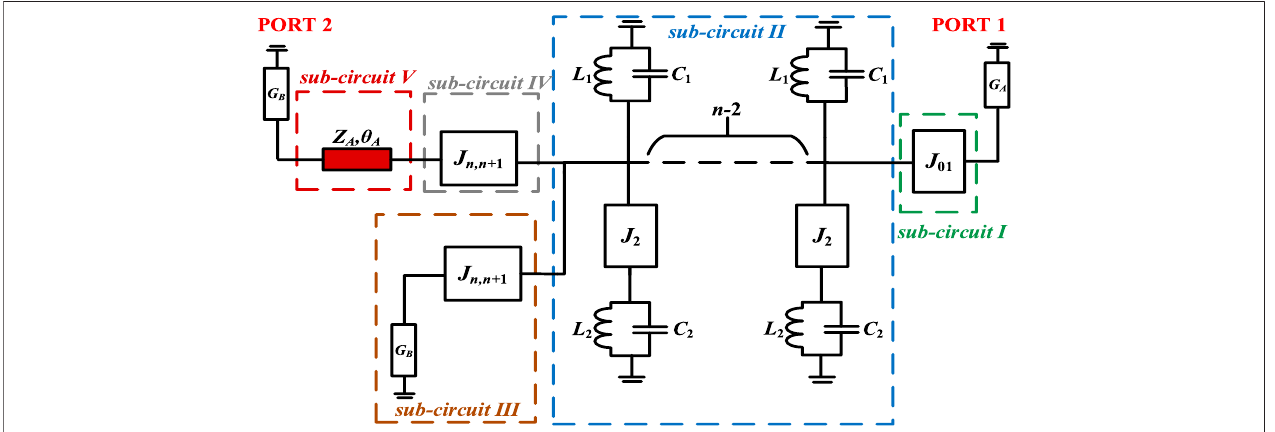
FIGURE 2 | Equivalent circuit diagram for analyzing phase difference between two output